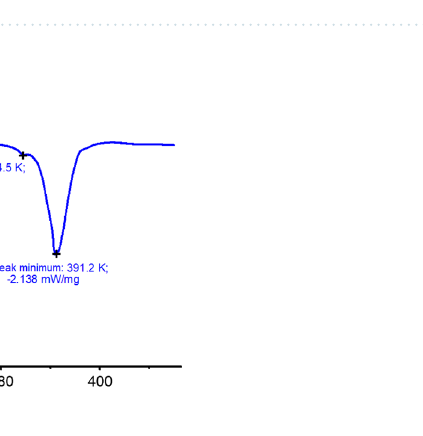
Figure 11. The DSC curves of struvite crystal possessing line defect. The peak at 384.5 K is associated with the existence of a